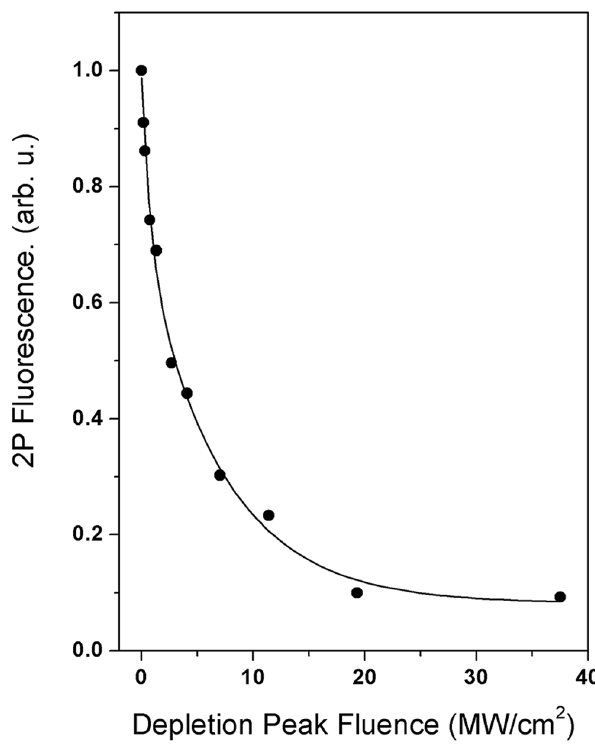
Figure 4. Two-photon excited fluorescence depletion of ATTO 425 depends on the 532 nm depletion beam.